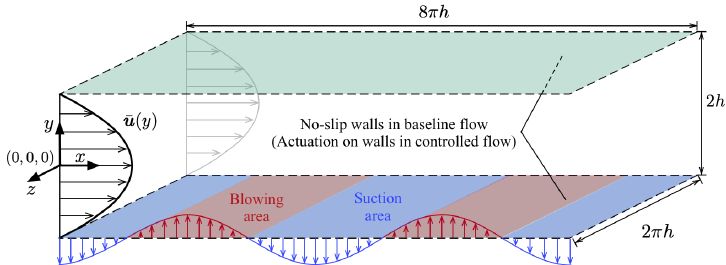
Figure 1. Schematic of plane Poiseuille flow with streamwise wave disturbance (not to scale), both with and without wall